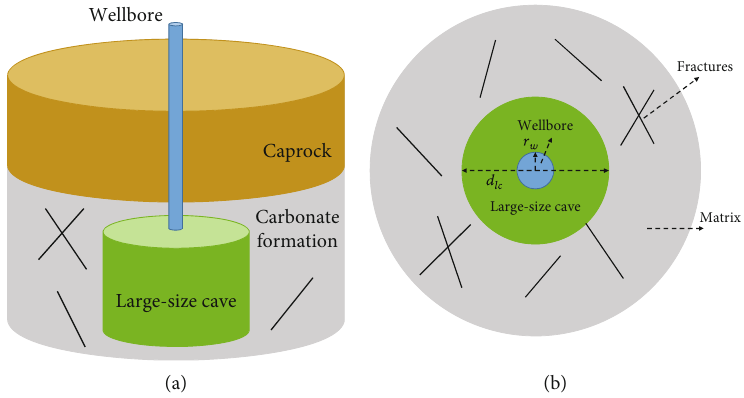
Figure 3: Physical model. (a) Front view of physical model. (b) Vertical view of physical model.